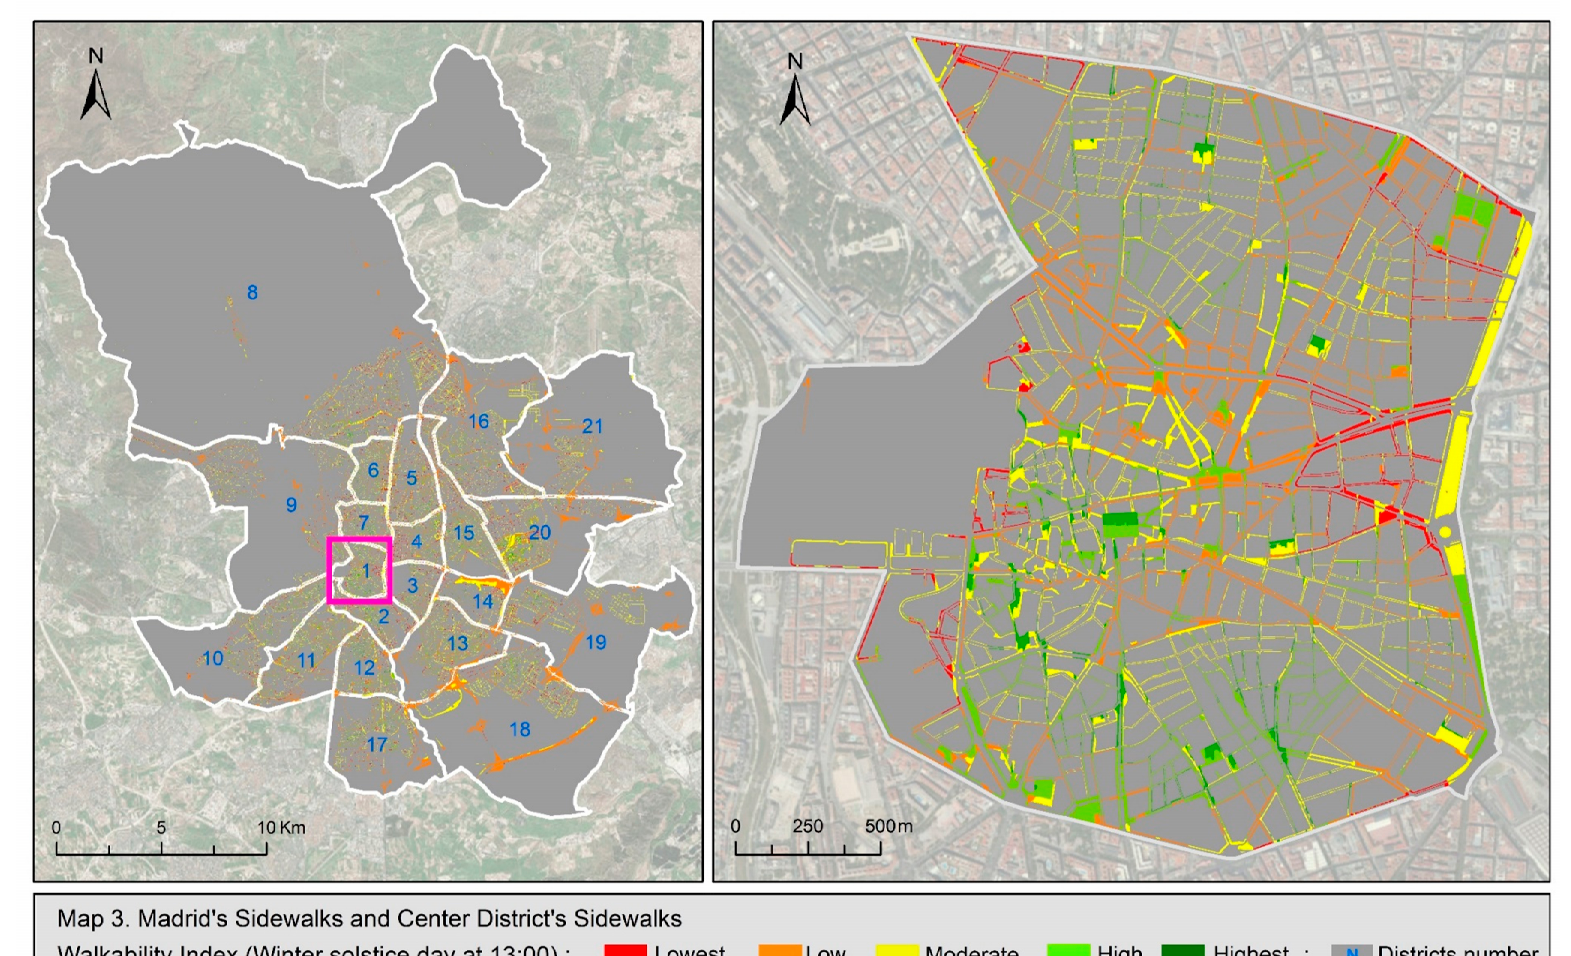
Figure A4. Walkability index results in the entire city and in the central district (detail) at 1 pm on winter